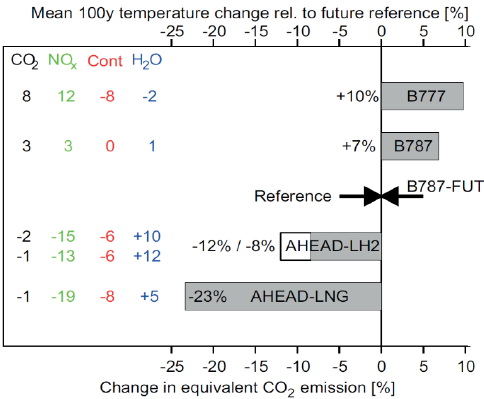
Figure 26. Change in average temperature response from 2051 to 2150 (ATR100) for fleets of different aircraft configurations relative to the reference configuration B787-FUT [43].